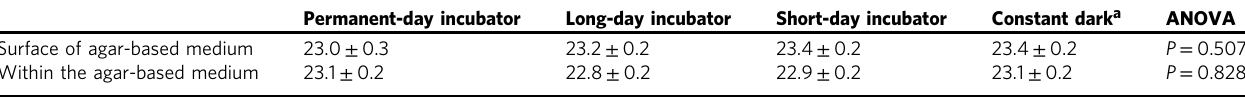
Table 1 Temperature of plates in incubators set at 22 °C and under different